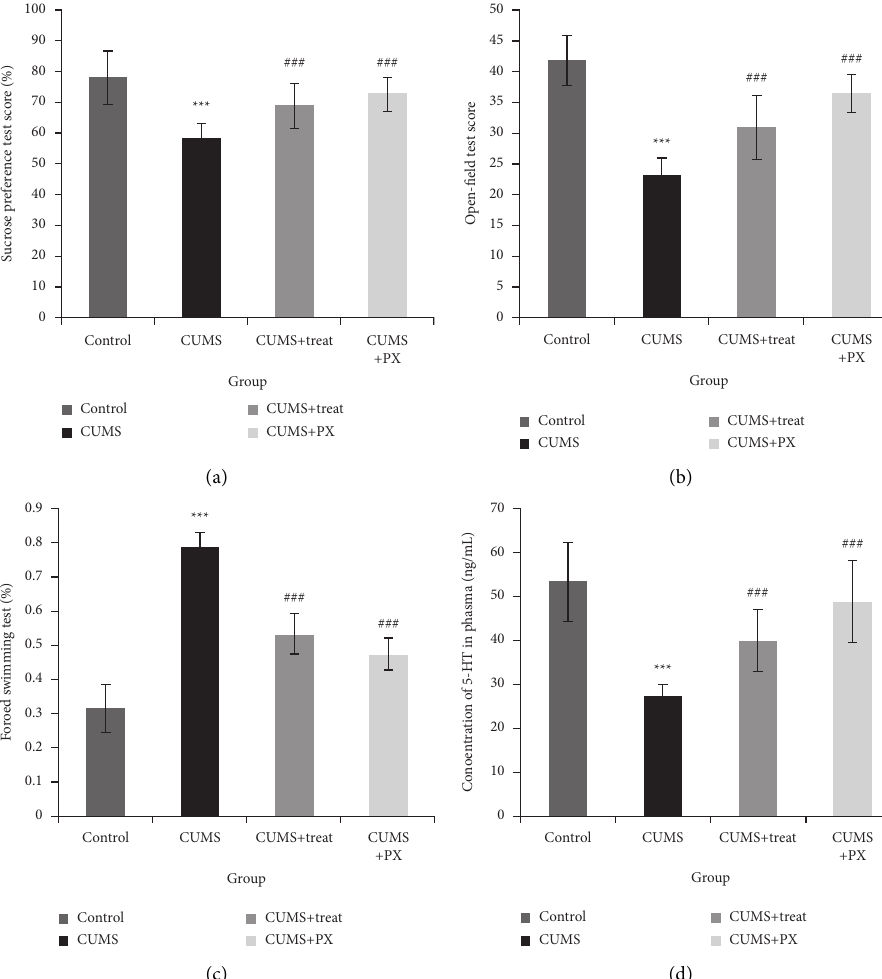
Figure 2: The results of rat behavioral tests and biochemical analysis in week 9 ( n � 6). The sucrose preference test (SPT) score (a), open-field test (OFT) score (b), and concentration of 5-HT in plasma (d) were lower, and the forced swimming test (FST) score (c) was higher in the CUMS group compared with the control group. While the SPT score (a), OFT score (b), and concentration of 5-HT in plasma (d) were higher, FST score was lower in CUMS +treat (ZZHPD treatment) group and CUMS +PX group compared with CUMS group. ∗ ∗ ∗ p < 0 . 001 different from control group; ## p < 0.01 ### p < 0.001 different from CUMS group (measured by one-way